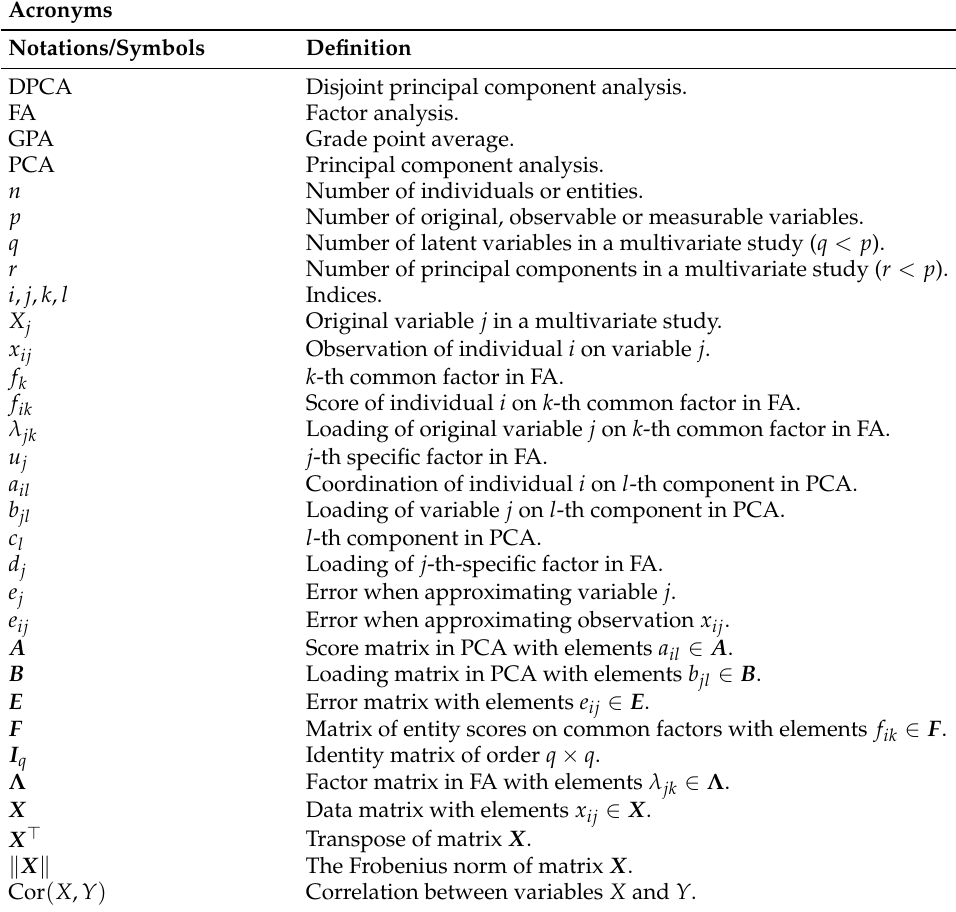
Table 1. Acronyms, notations, and symbols employed in the present